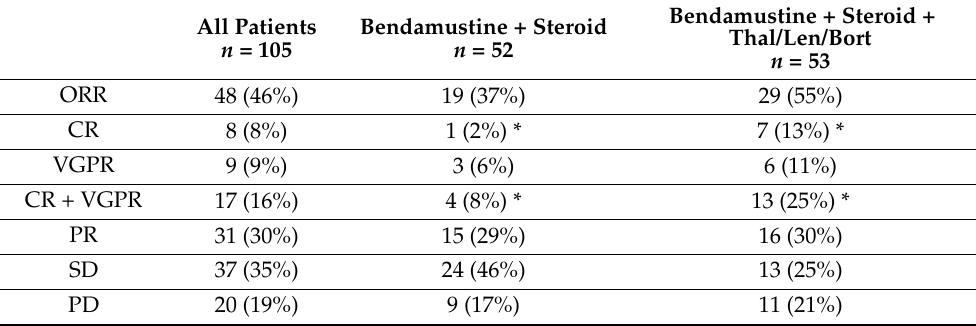
Table 2. Response to bendamustine-based